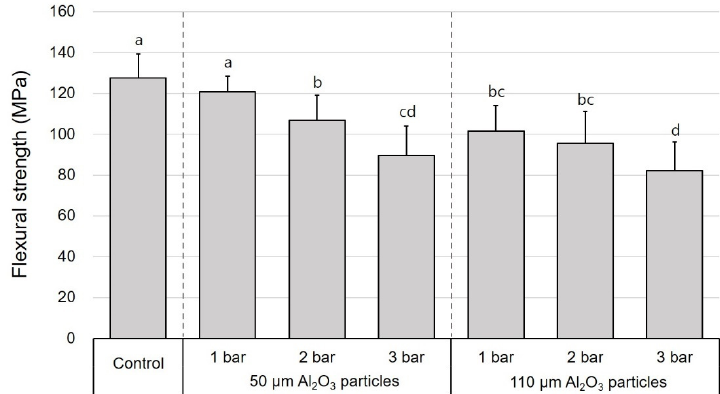
Figure 3. One-way ANOVA and post-hoc test results for the effects of the entire group of surface treatments on the flexural strength of polymer-infiltrated ceramic networks specimens with respect to Al 2 O 3 particle size and air abrasion pressure (mean + standard deviation). Different lowercase superscript letters indicate significant differences in flexural strength.